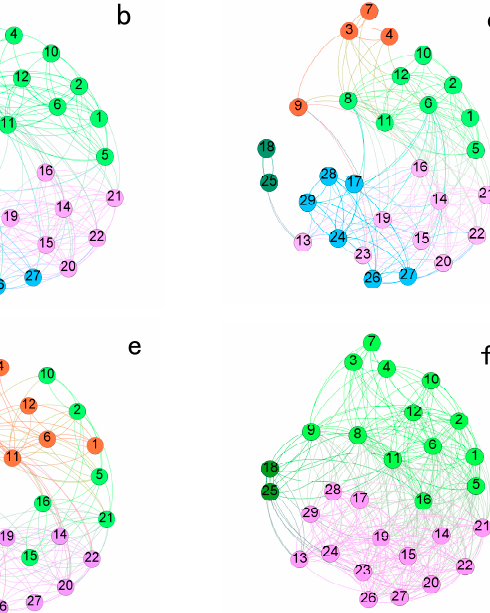
Figure 11. Topology views with the same layout method: ( a ) layer1, ( b ) layer2, ( c ) layer3, ( d ) the overlap layer of layer1 and layer2, ( e ) the overlap layer of layer1, layer2, and layer3, and ( f ) the aggregation layer.